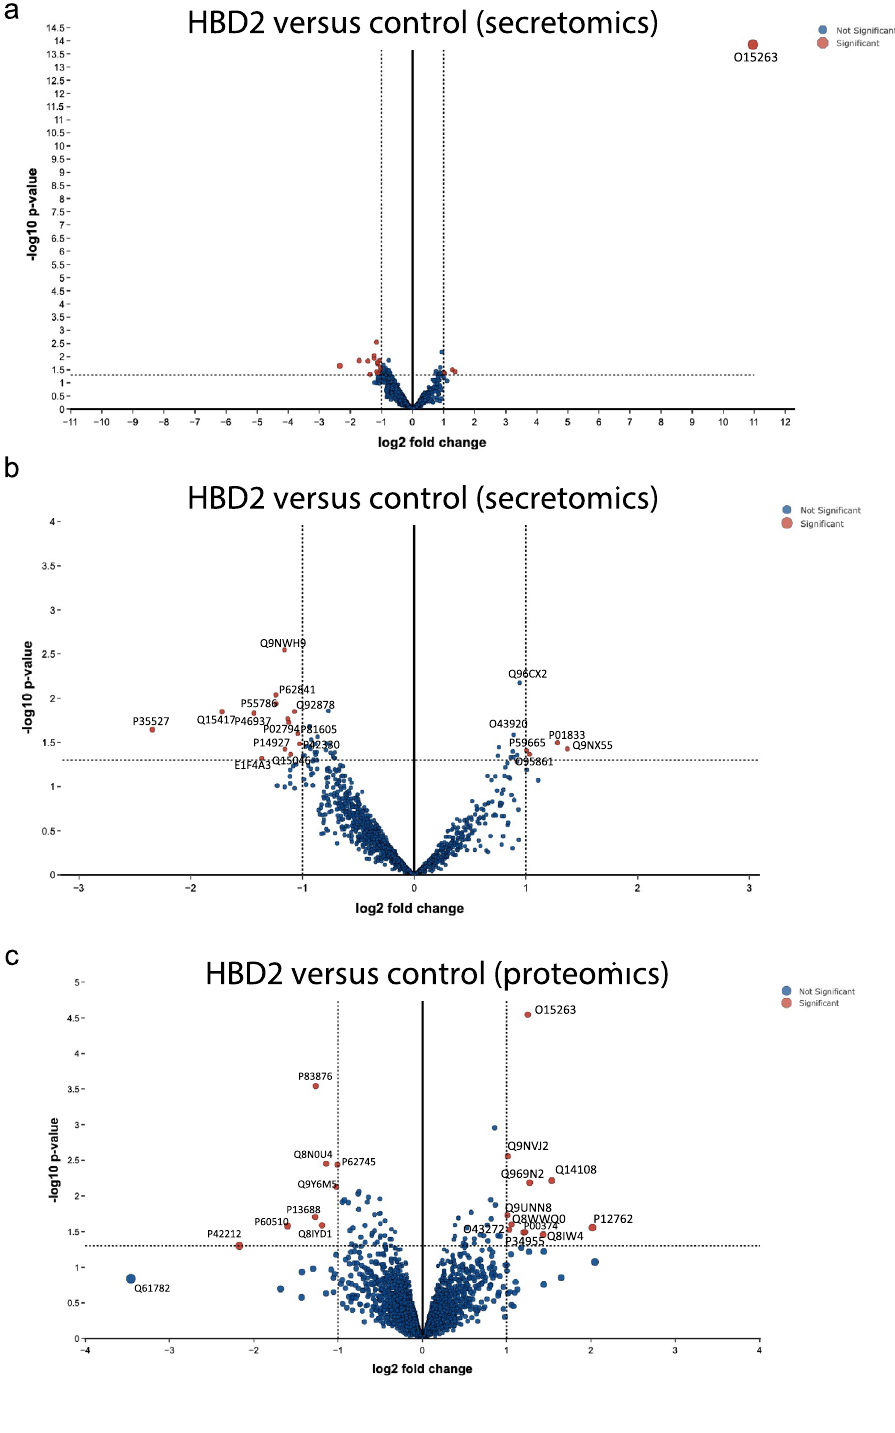
Figure 5. Secretomic and proteomic analyses of HBD2-stimulated HaCaT cells. HaCaT cell monolayers were treated with 0.5 μg/ml HBD2, or vehicle control, in serum free media for 48 h before supernatants ( a , b ) and cells ( c ) were collected and centrifuged at 3000 rpm for 5 min. Media ( a , b ) and dry cell pellet ( c ) were stored at -80 °C prior to analysis. Data representative of n = 5. Log fold changes and p values generated using LIMMA pathway 37 . ( a , b ) Volcano plots generated from secretomics analysis of HBD2-stimulated HaCaT cells compared to control vehicle-treated cells. Red points indicate significant points, blue indicate nonsignificant points. ( a ) Data represented as a whole. ( b ) Data represented without O15263 data point, zoomed in to central portion of graph. ( c ) Volcano plot generated from proteomics analysis of HBD2-stimulated HaCaT cells compared to control vehicle-treated cells. Red points indicate significant points, blue indicate nonsignificant